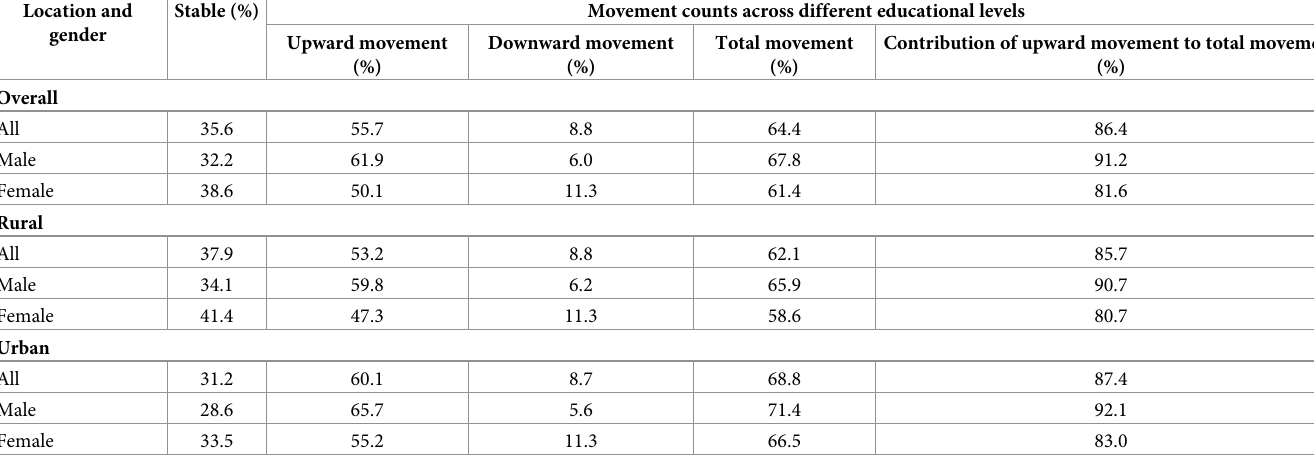
Table 2. Intergenerational educational class movements. Location and Stable gender